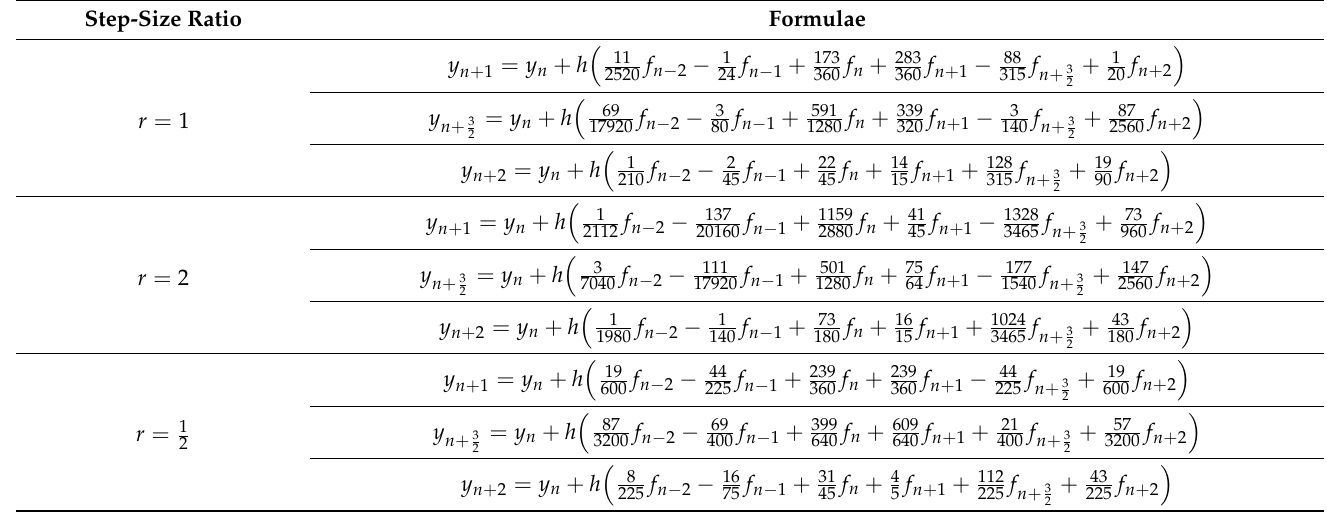
Table 1. VSHBM Formulae at different step size